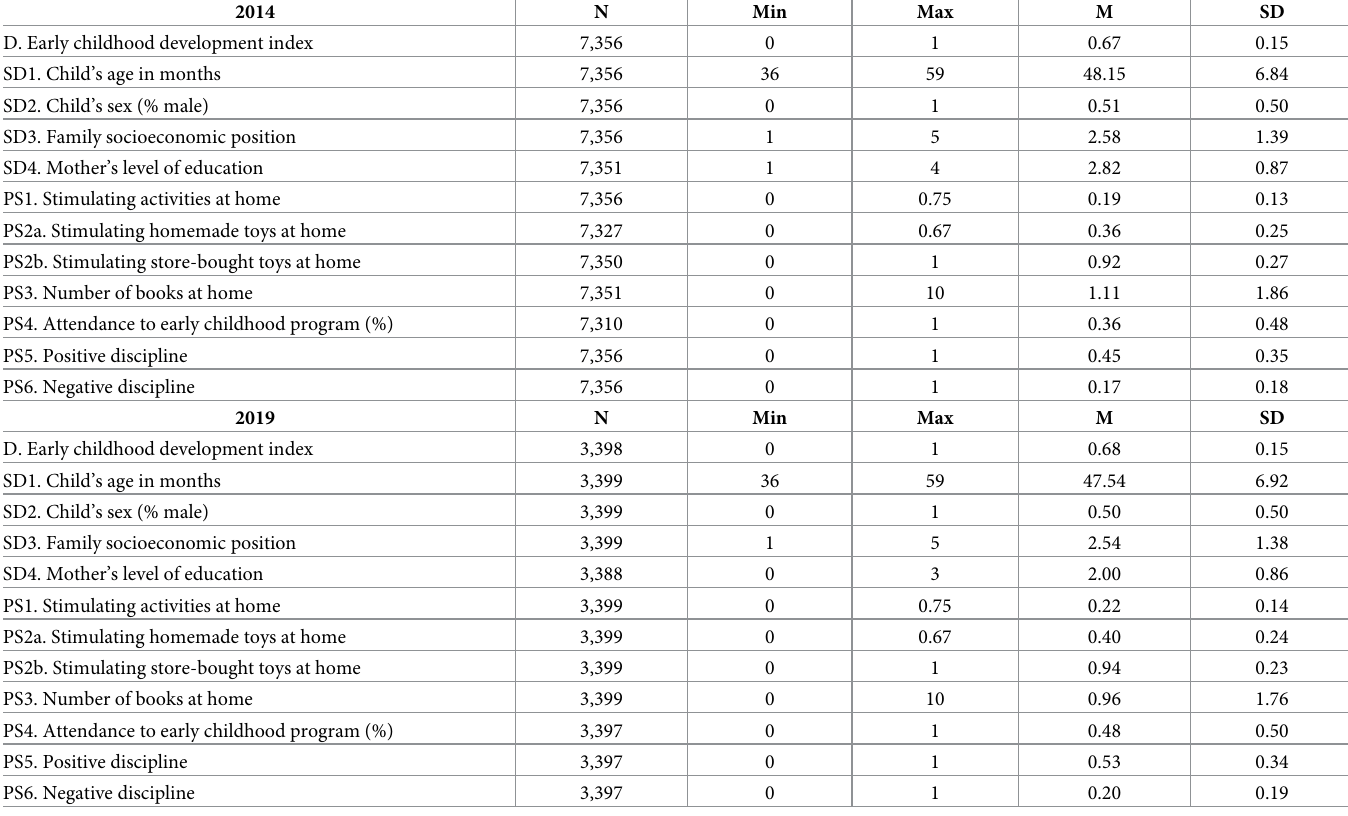
Table 2. Descriptive statistics for tested variables, MICS Dominican Republic 2014 and